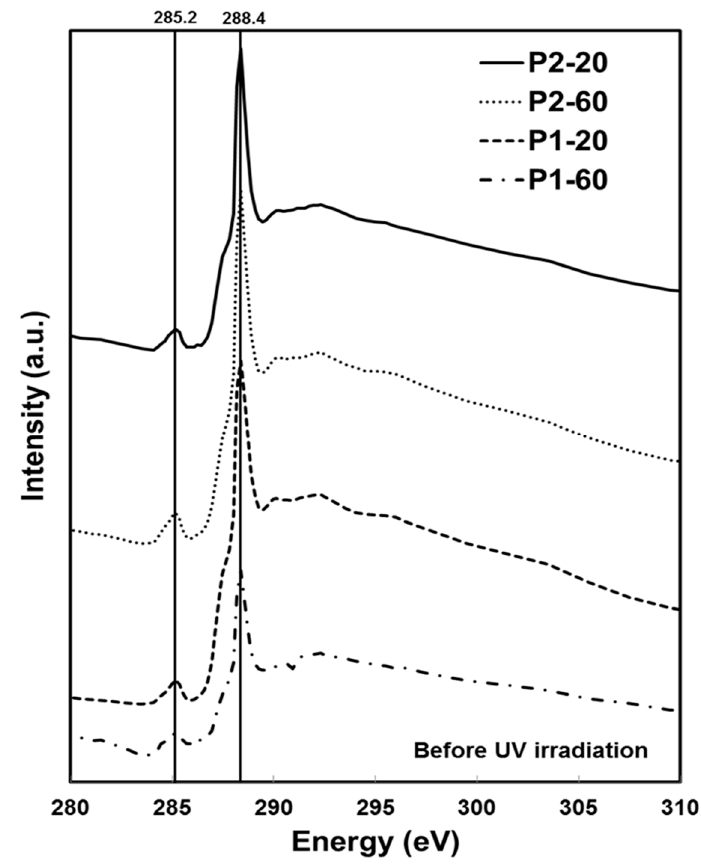
Figure 4. Near-edge X-ray absorption fine structure (NEXAFS) C1s K-edge spectra for P1-20, P1-60, P2-20, and P2-60 before UV irradiation.